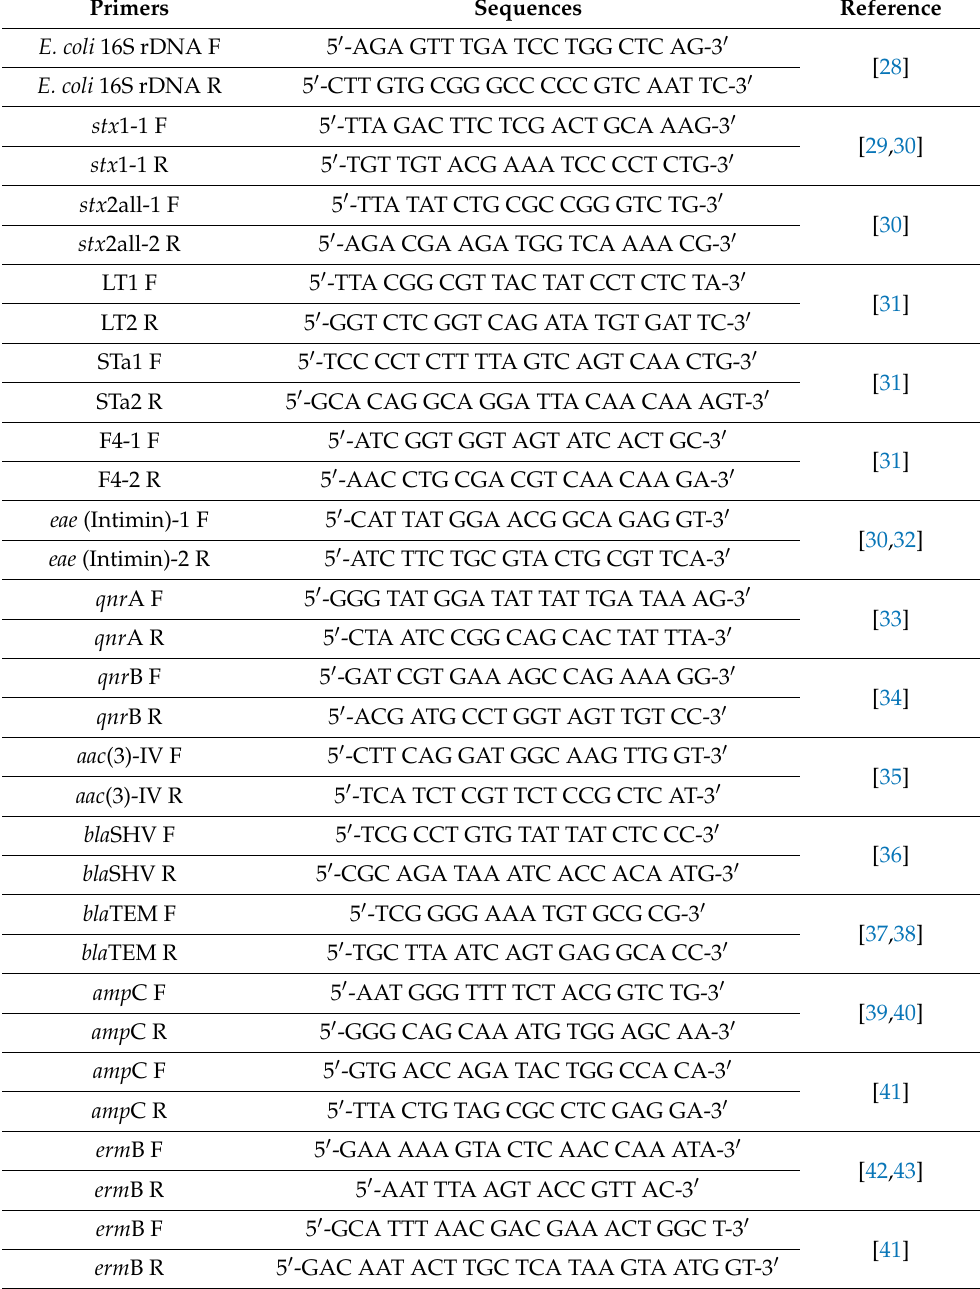
Table 4. List of primers used in this study with their